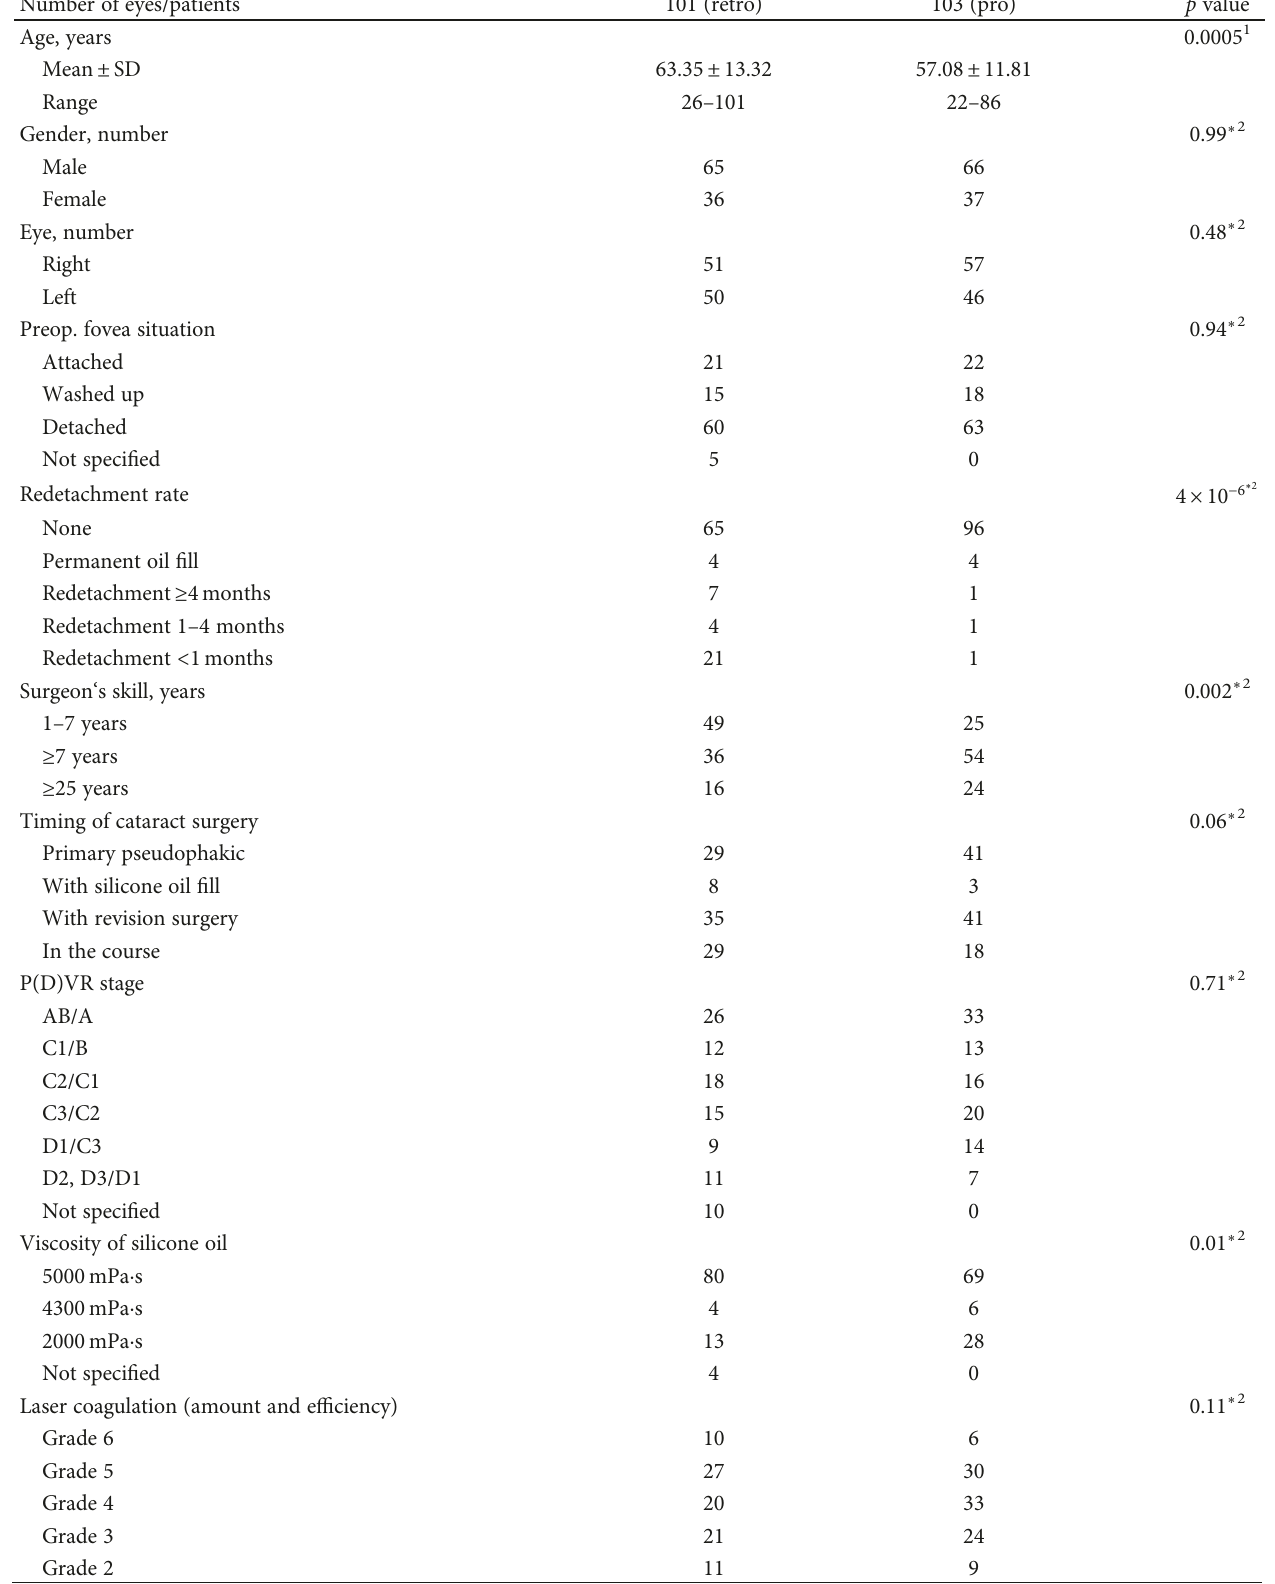
Table 1: Parameters of population and surgery (retrospective versus prospective) and their statistical